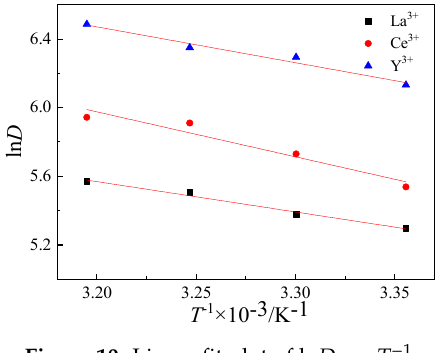
Figure 10. Linear fit plot of ln D vs. T − 1. Table 3. Thermodynamics parameters for La(III), Ce(III), and Y(III) adsorption by resin.